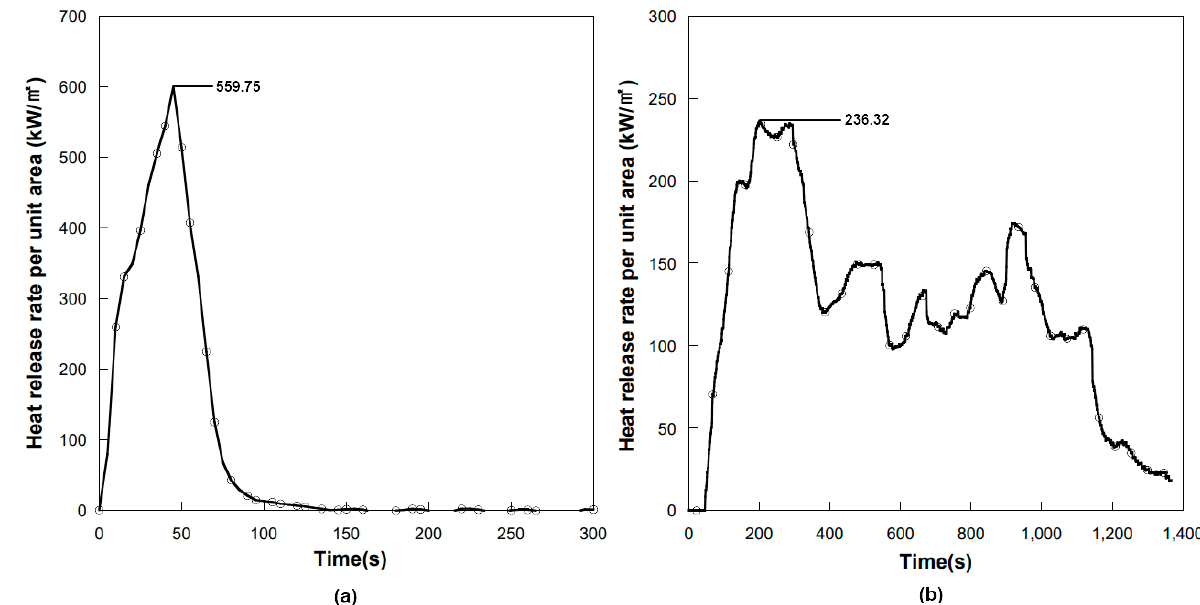
Figure 4. Heat Release Rate Per Unit Area (HRRPUA) for ( a ) polyurethane foam (PUF) and ( b ) Wood Crib.